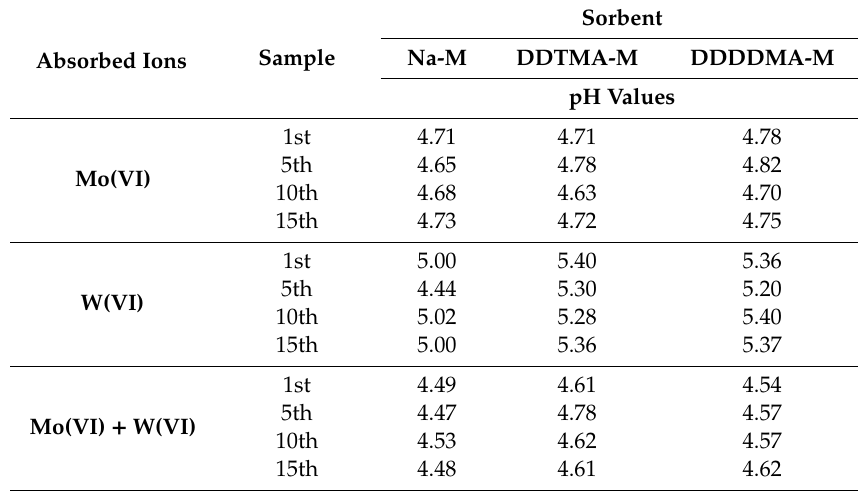
Table 2. pH values of the solutions remaining after sorption of Mo(VI), W(VI), and Mo(VI) + W(VI). Initial pH = 4, T = 20 ◦ C, C 0 = 50